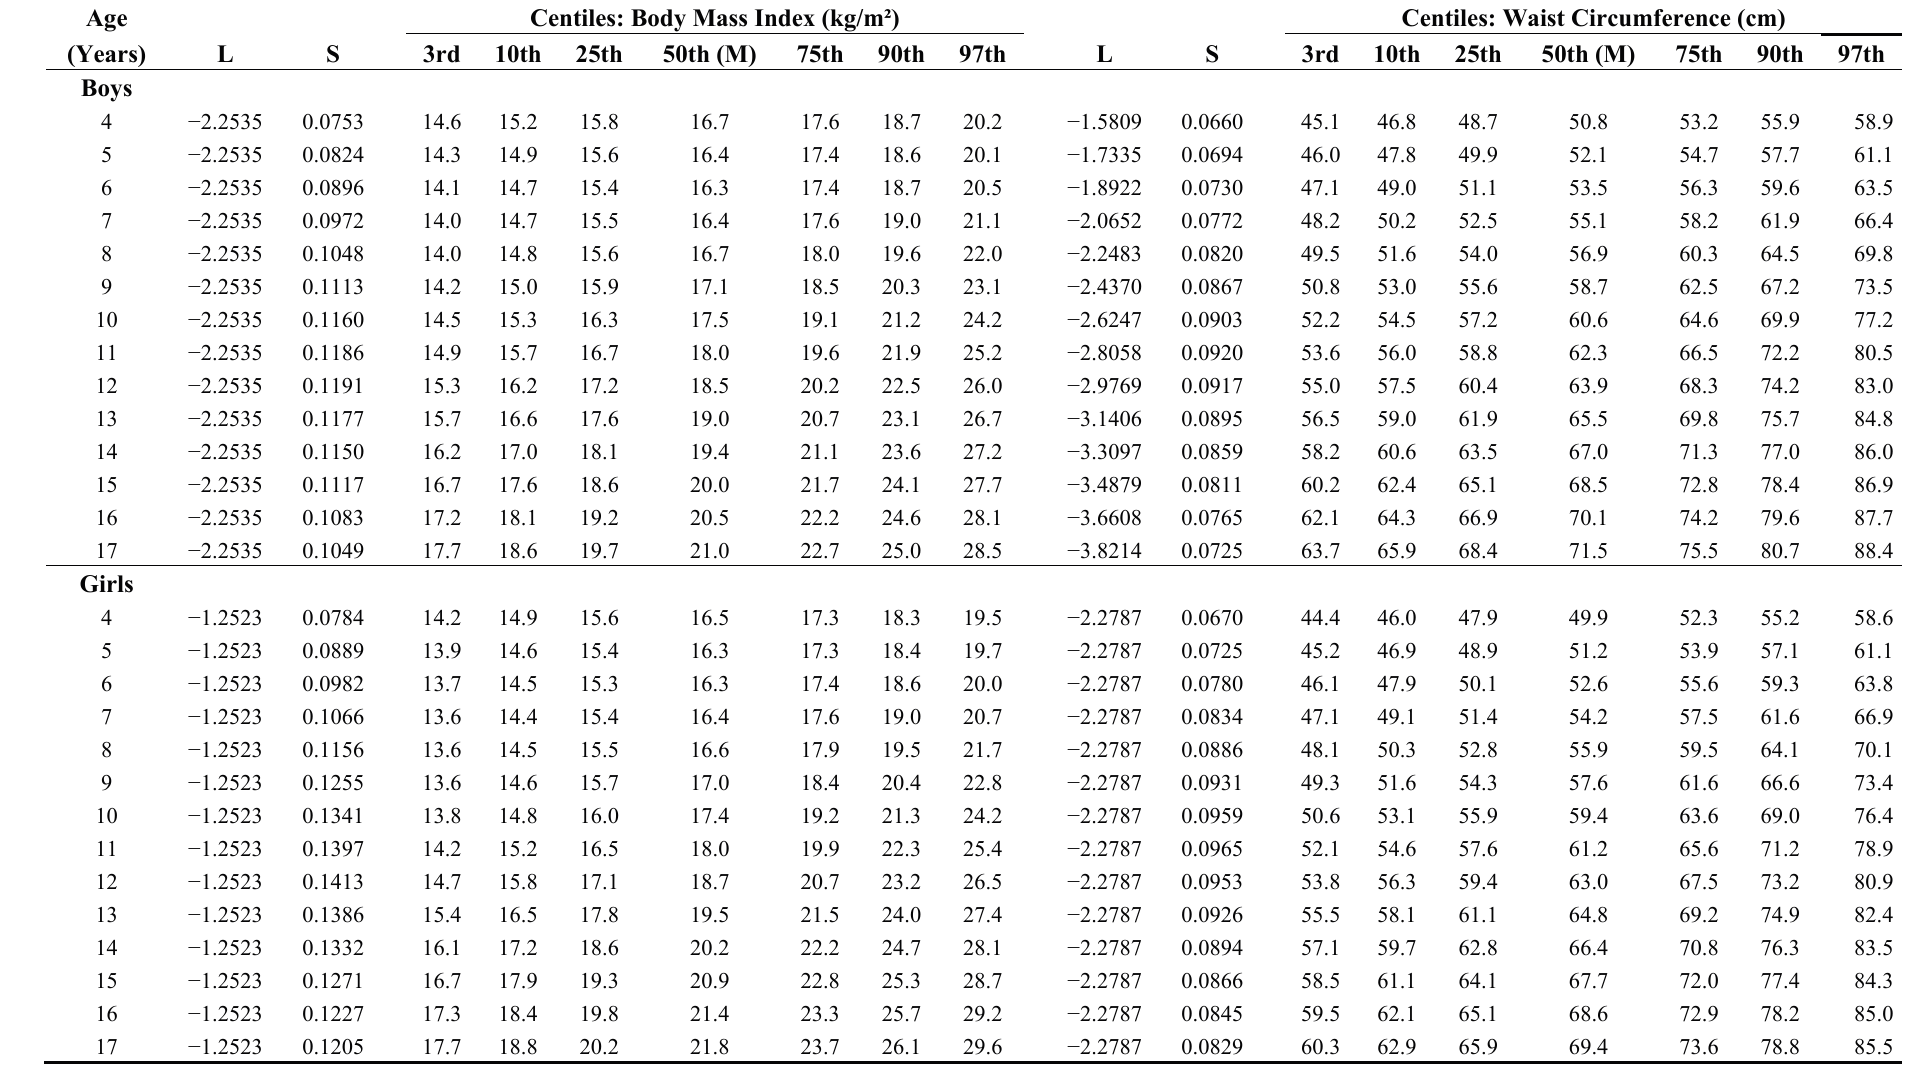
Table 5. Age- and sex-specific percentiles of body mass index (kg/m²) and waist circumference (cm) for school-aged Peruvian children and adolescents. Age Centiles: Body Mass Index (kg/m²) Centiles: Waist Circumference